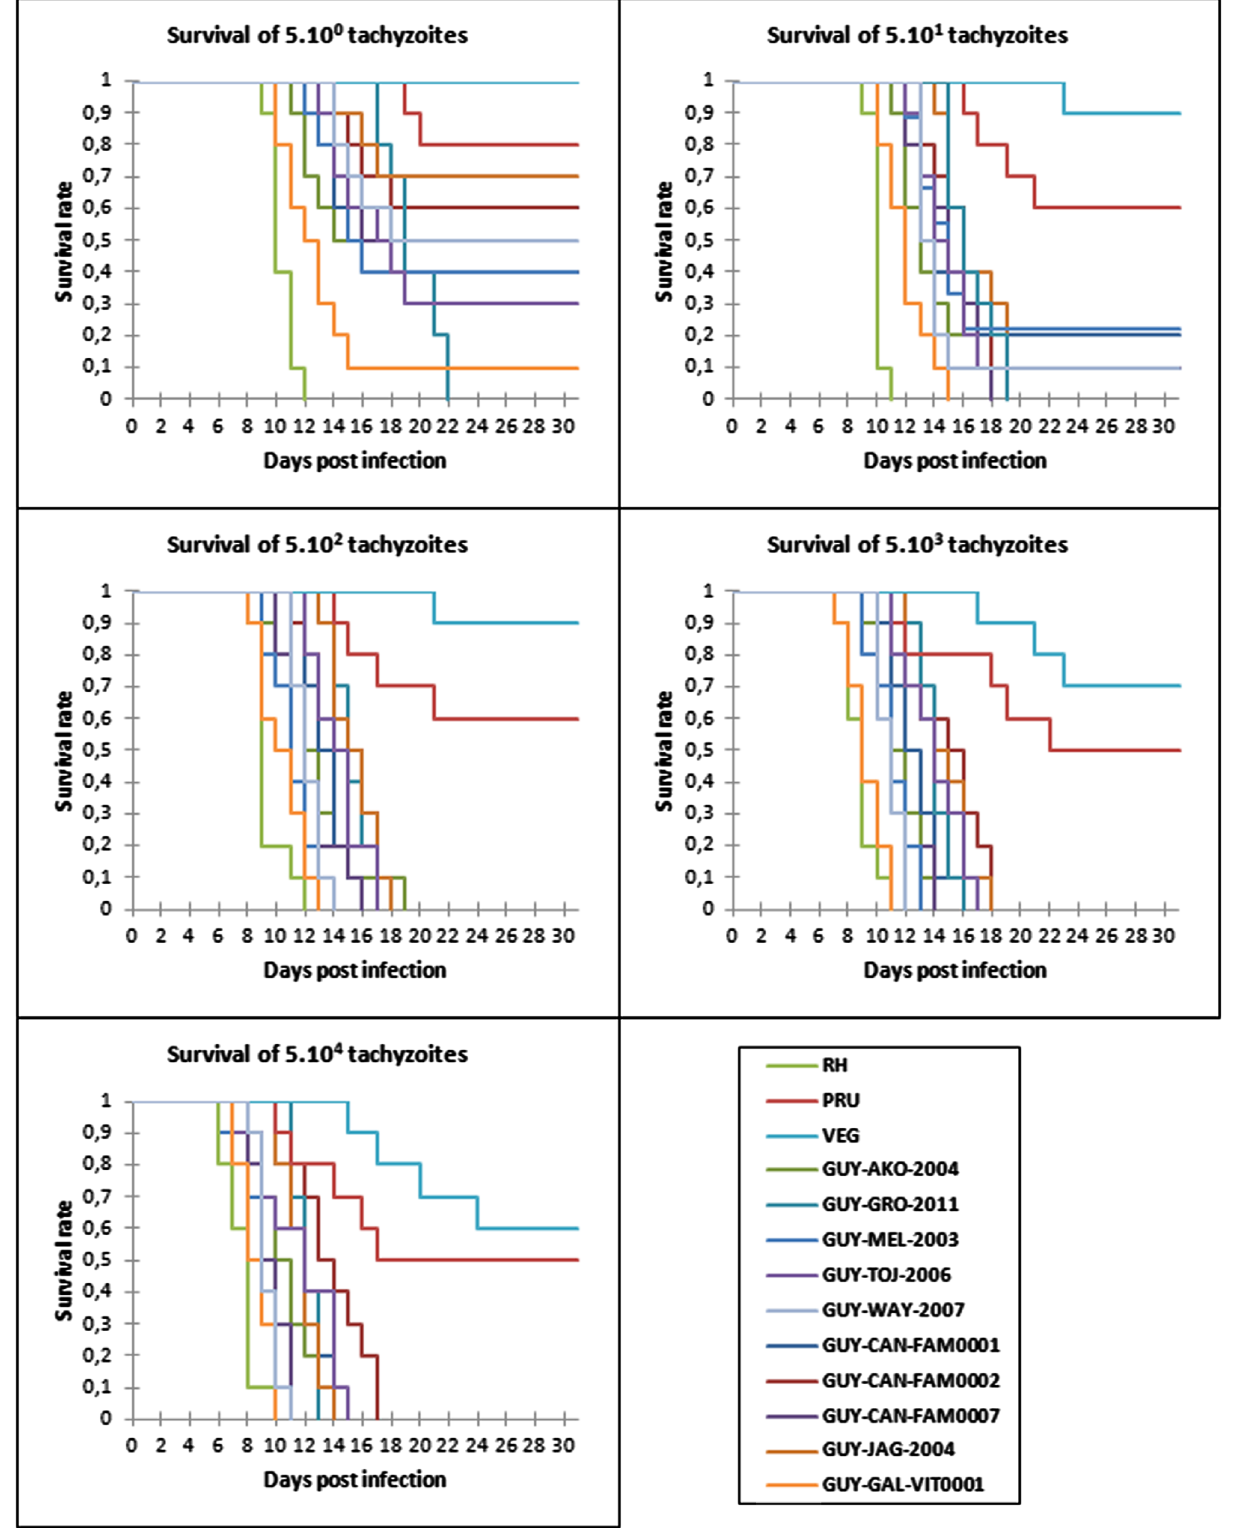
Figure 1. Virulence in mice of atypical Toxoplasma gondii strains isolated in French Guiana compared to reference strains (type I, II and III). Ten mice/groups were inoculated intraperitoneally with different doses of tachyzoites for each strain, and the viability of mice was monitored daily. Survival was followed up for 31 days after injection and data were plotted as Kaplan-Meier curves (statistical signi fi cance of survival curves between RH and others strains, p (cid:3)